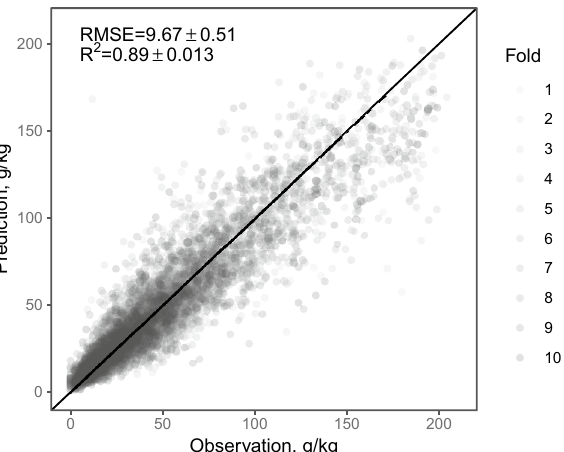
Figure 2. Observed vs predicted soil organic carbon (SOC) from a 10-fold cross-validation. The solid 1:1 line is drawn for reference.